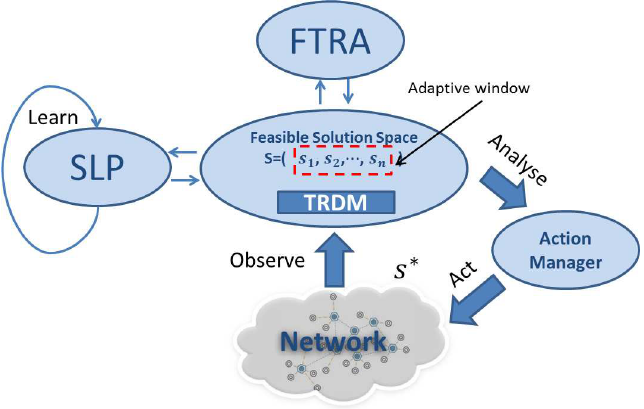
Figure 3. The dynamic task allocation